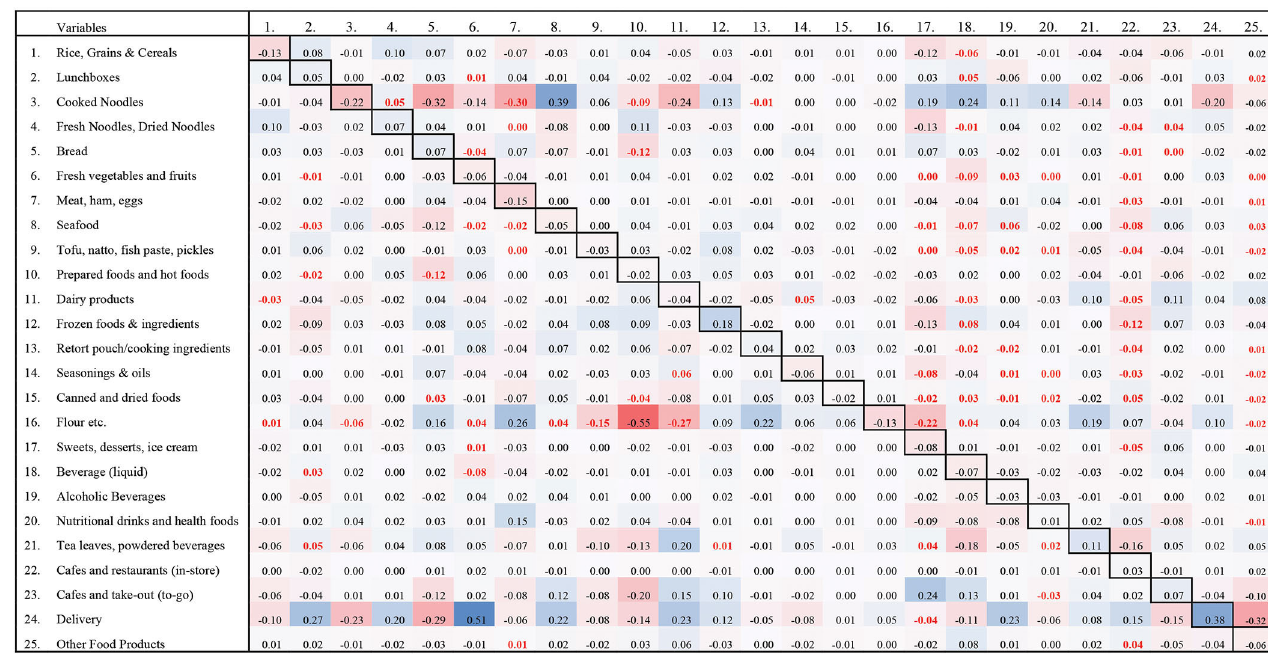
TABLE 7 Rate of change in cross price elasticities from 2019 to 2020 (Model